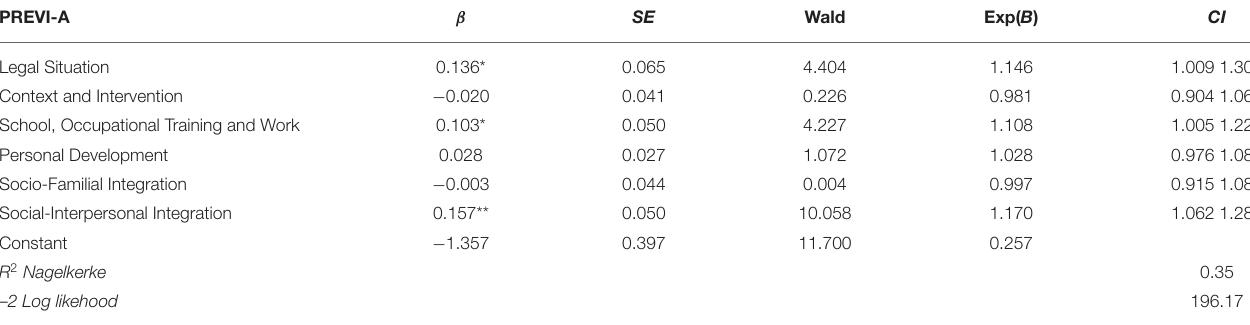
TABLE 3 | Hierarchical logistic regression model predicting criminal recidivism on PREVI-A